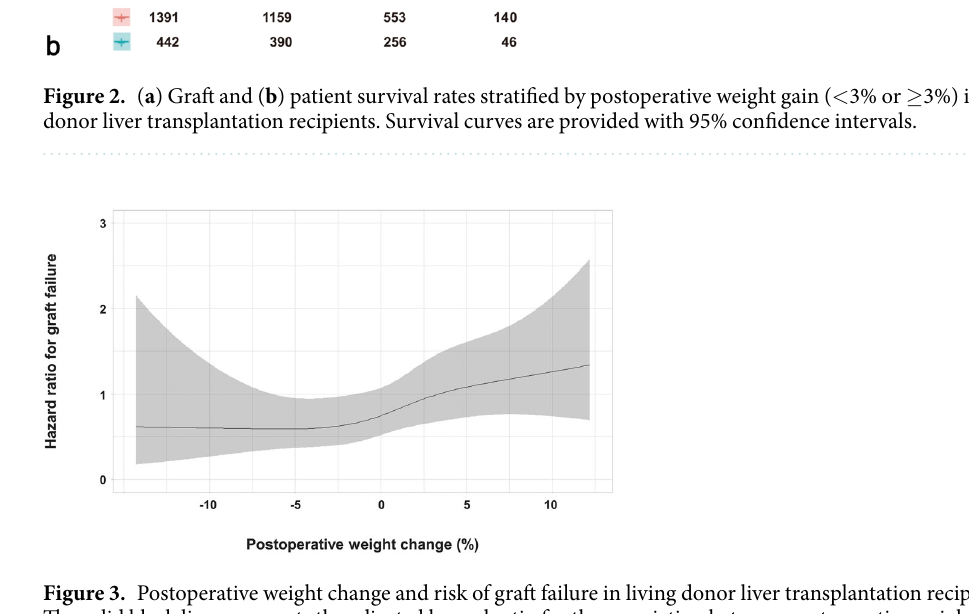
Figure 3. Postoperative weight change and risk of graft failure in living donor liver transplantation recipients. The solid black line represents the adjusted hazard ratio for the association between postoperative weight change and graft failure, and grey shading represents the 95% confidence interval of the estimate. Postoperative weight change was modelled with restricted cubic splines with 5 knots (5 th , 27.5 th , 50 th , 72.5 th , and 95 th percentiles) in a multivariate Cox model, which was adjusted for all variables in Table